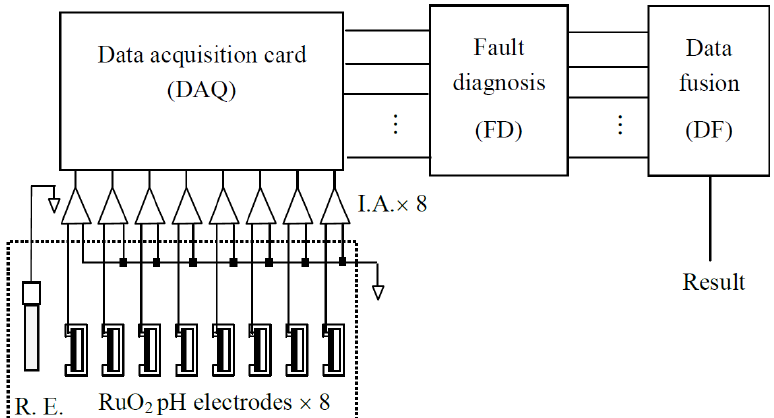
Figure 2. Measurement system used for the ruthenium dioxide pH sensor array with a data acquisition card to acquire data. The data were used to perform fault diagnosis and data